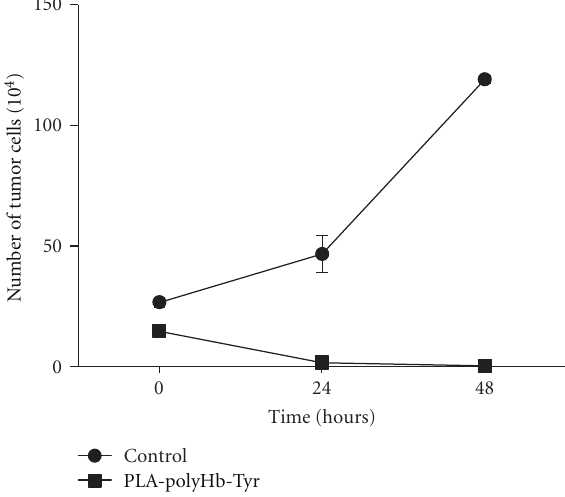
Figure 8: The e ff ects of PLA nanocapsule [polyHb-Tyr] on the attachment ability of B16F10 melanoma cells.